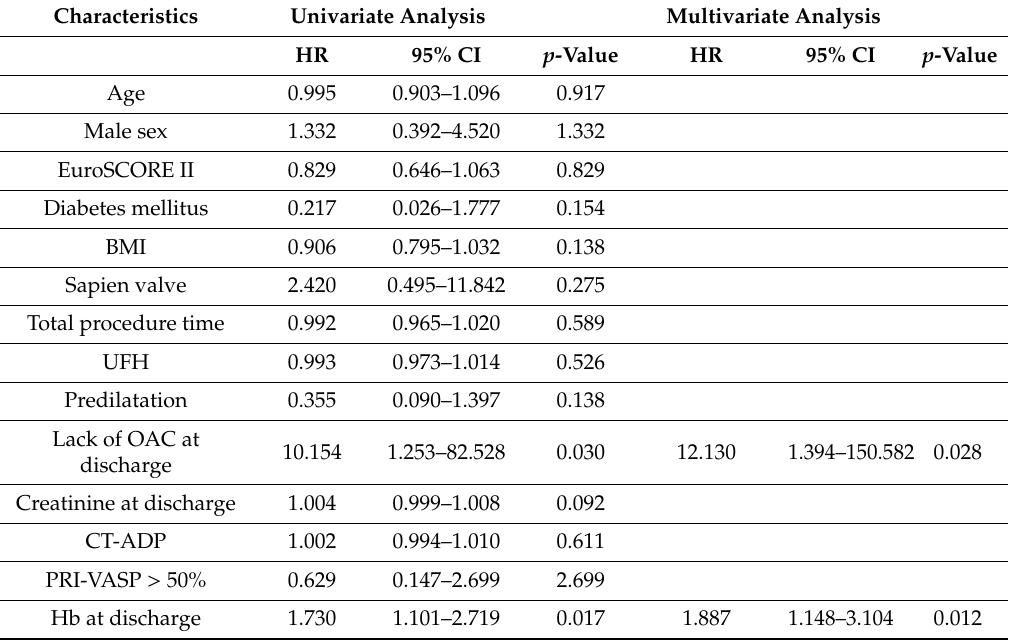
Table 4. Predictors of HAM.